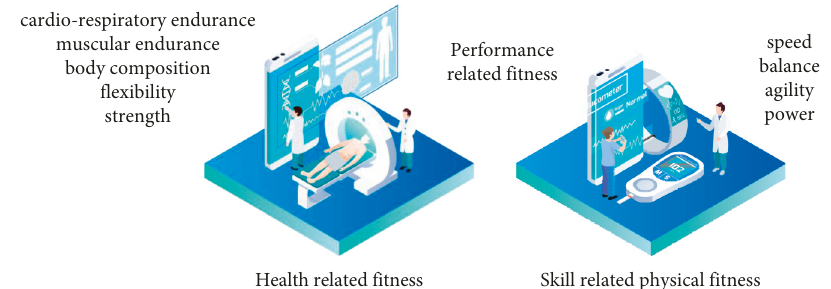
Figure 1: The main components of physical